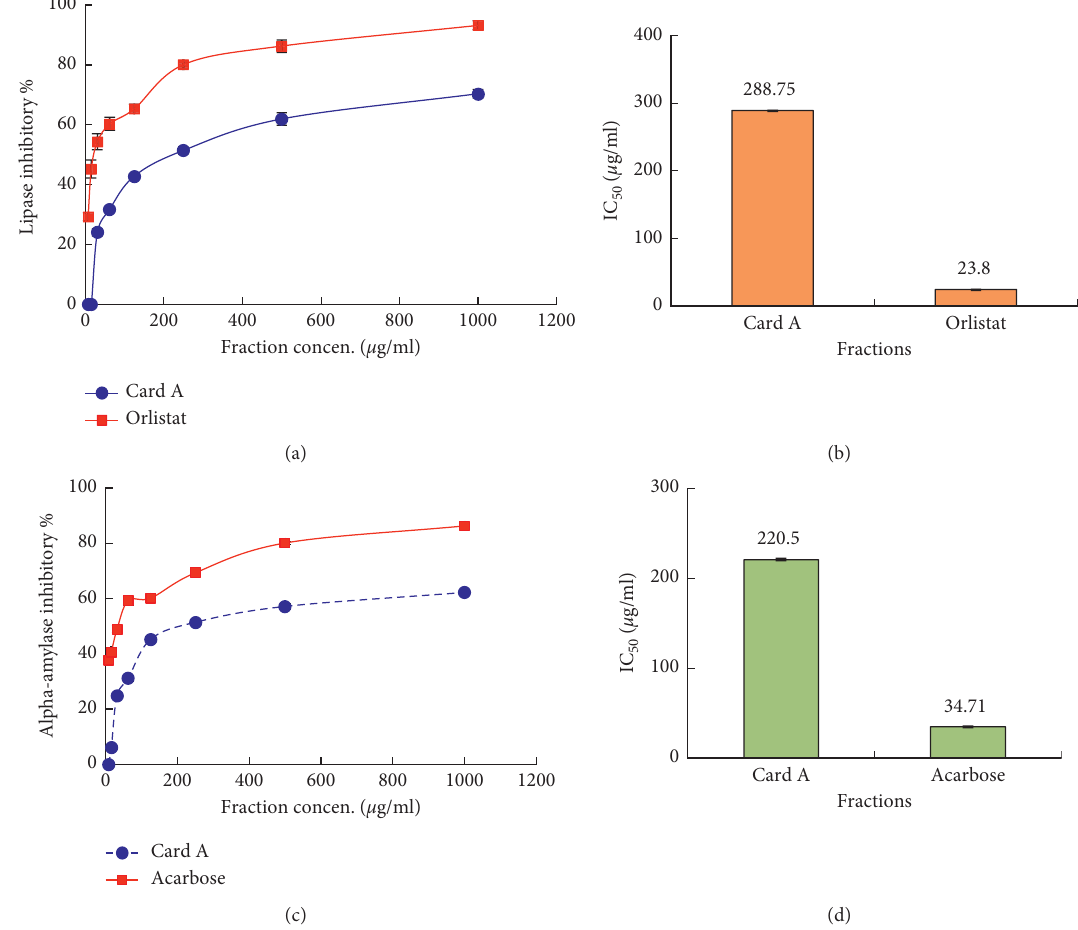
Figure 3: (a) In vitro pancreatic lipase inhibitory activity percentage of E. cardamomum L . aqueous extract (Card A) compared to orlistat standard. (b) IC 50 of E. cardamomum L. aqueous extract (Card A) and orlistat. (c) In vitro α -amylase inhibitory activity of E. cardamomum L. aqueous extract (Card A) compared to acarbose standard. (d) IC 50 of E. cardamomum L. aqueous extract (Card A) and acarbose. Data are presented as averages ± standard deviations from three